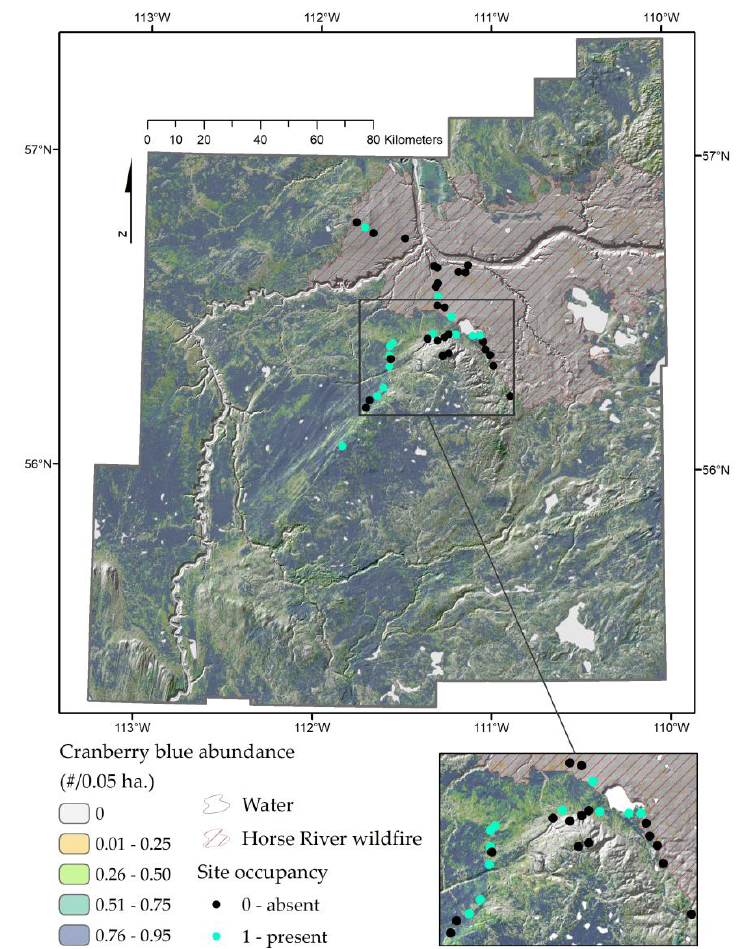
Figure 5. Predicted posterior mean of the abundance of cranberry blues ( λ , with N ~Poisson ( λ )) associated to a habitat suitability process based on forest wetness, canopy height, their interactive term, as well as the 2016 Horse River Wildfire. Blue cells represent the most suitable forests for cranberry blues.